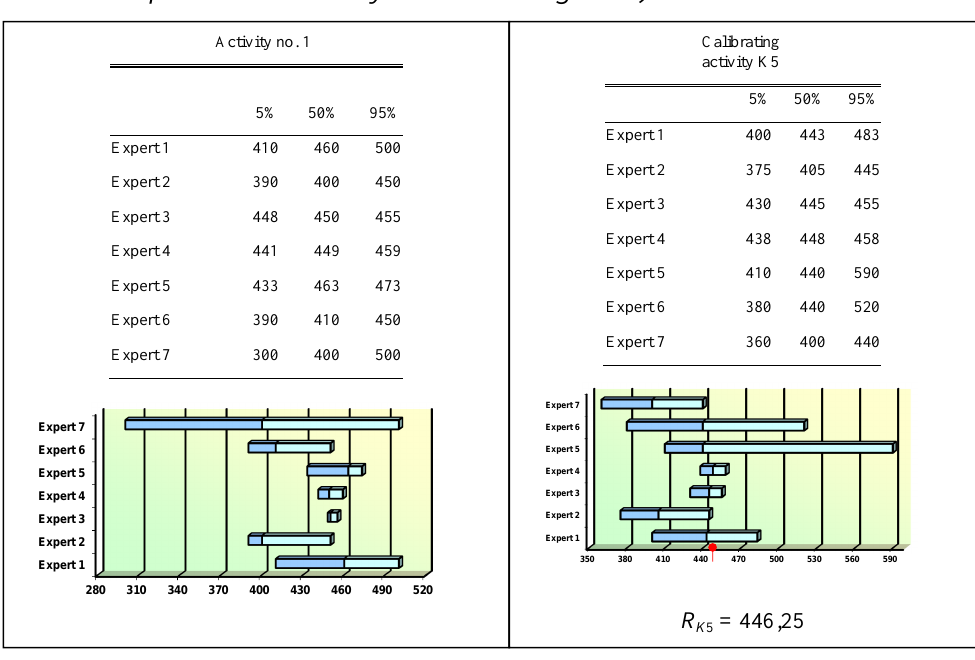
Table 3 – Sample of Interval Estimations of the Risk Determined by Individual Experts for Activity no. 1 and the Calibrating Activity K5 (Value RK5 represents the actually known resulting